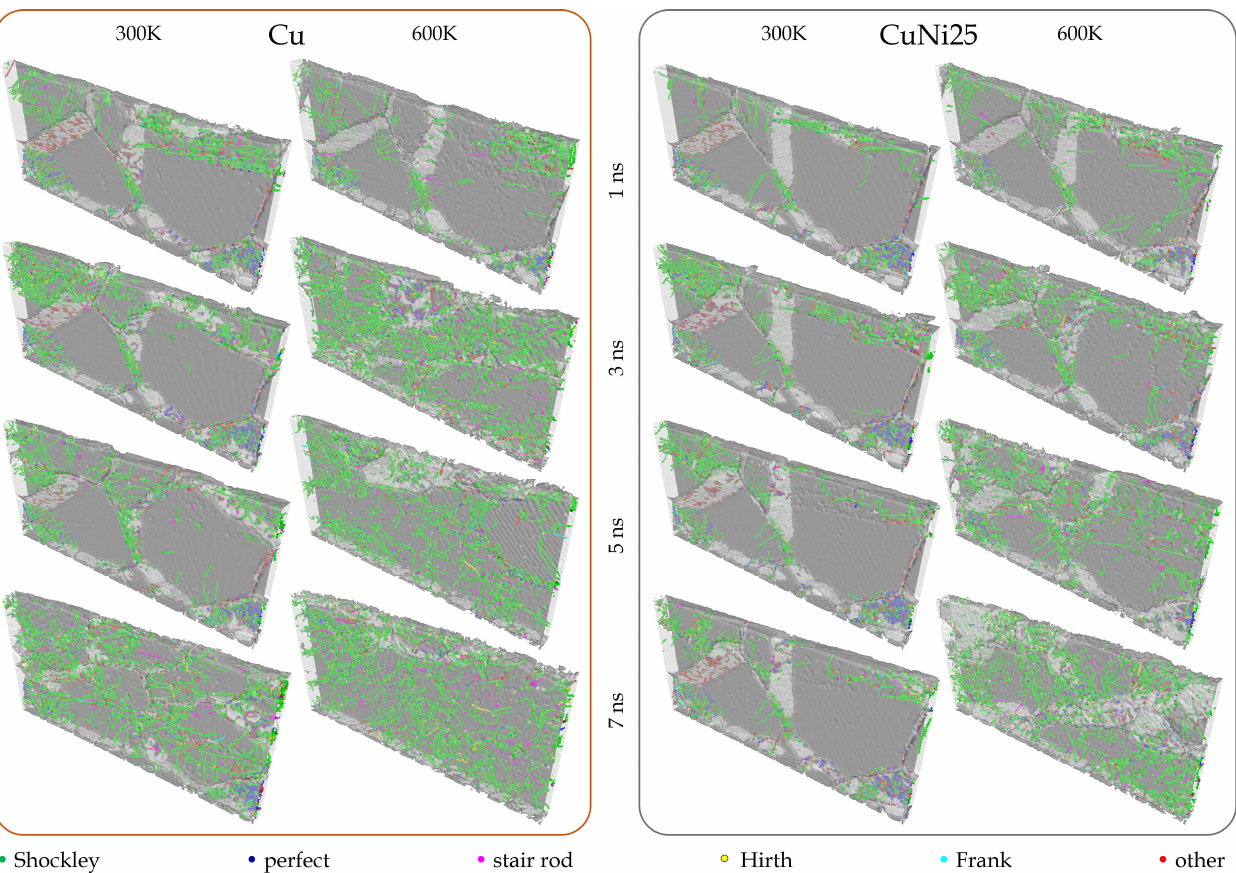
Figure 5. Time-resolved dislocation analysis at 0.4 GPa. Slab dimensions are 85 nm × 40 nm × 5 nm. From left to right column: Cu at 300 K, Cu at 600 K, CuNi25 at 300 K, CuNi25 at 600 K. Coloring by dislocation type (green: Shockley, blue: perfect, magenta: stair rod, yellow: Hirth, cyan: Frank, red: